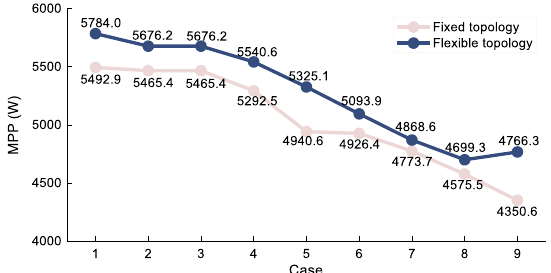
Fig. 12 MPPs of the TCT connected PV array for the 9 cases in Scenario 5